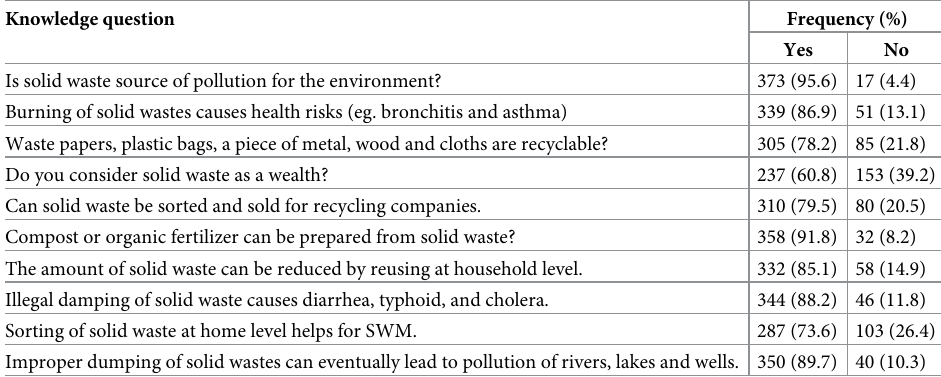
Table 2. Households‘response to knowledge questions on SWM.